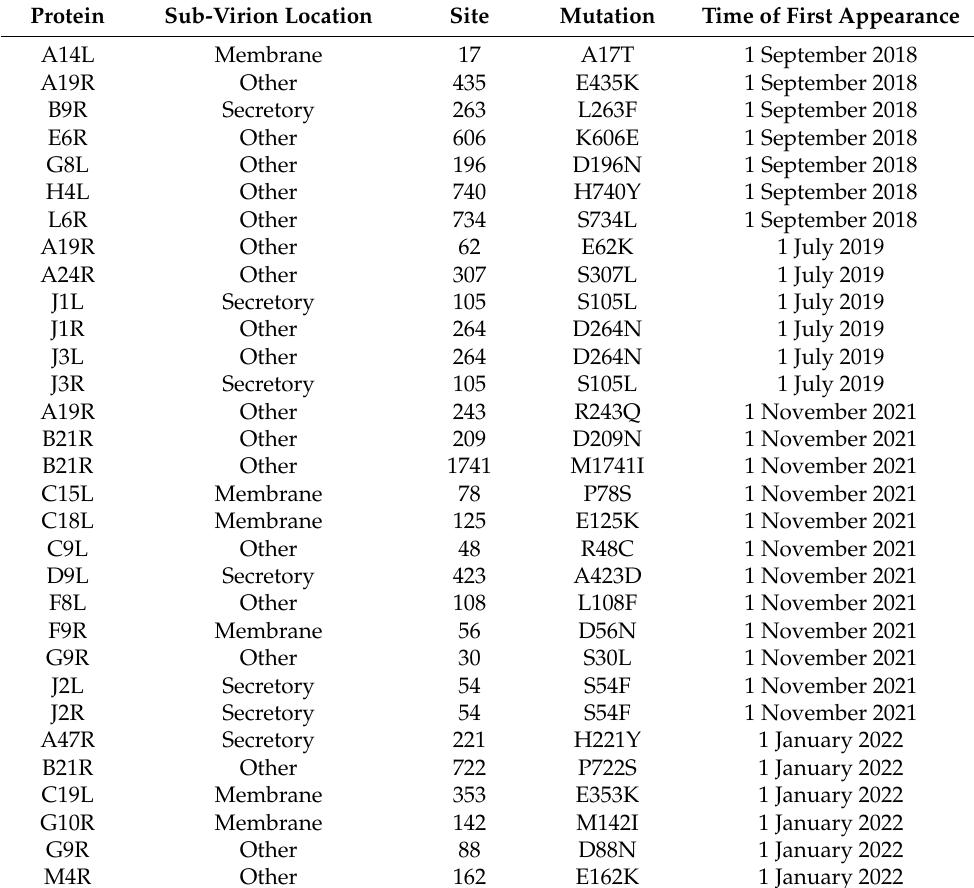
Table 2. Frequent amino acid